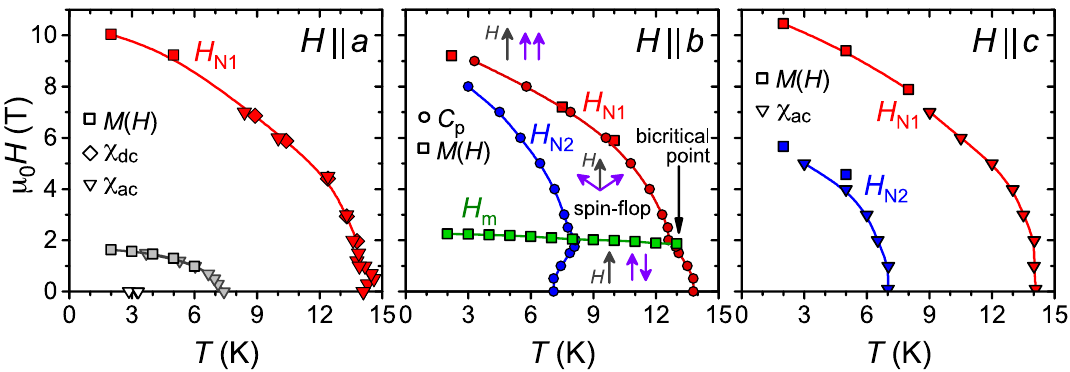
Figure 5. H – T phase diagrams for magnetic fields aligned along different crystallographic directions, left: H (cid:31) a , center: H (cid:31) b , right: H (cid:31) c , as extracted from ac and dc susceptibility χ , magnetization M and specific heat C p measurements. Violet arrows depict a possible magnetization orientation with respect to magnetic field (gray arrows). To enable comparison, sample demagnetization effects are taken into